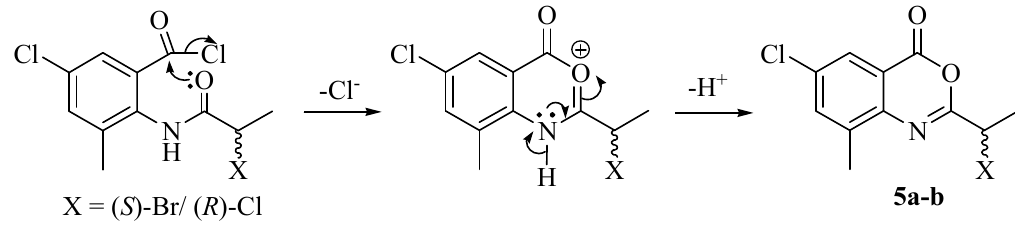
Scheme 2. Mechanism showing the formation of 6-chloro-2-(1'-haloethyl-8-methyl-3,1- benzoxazine-4-one 5a – b .